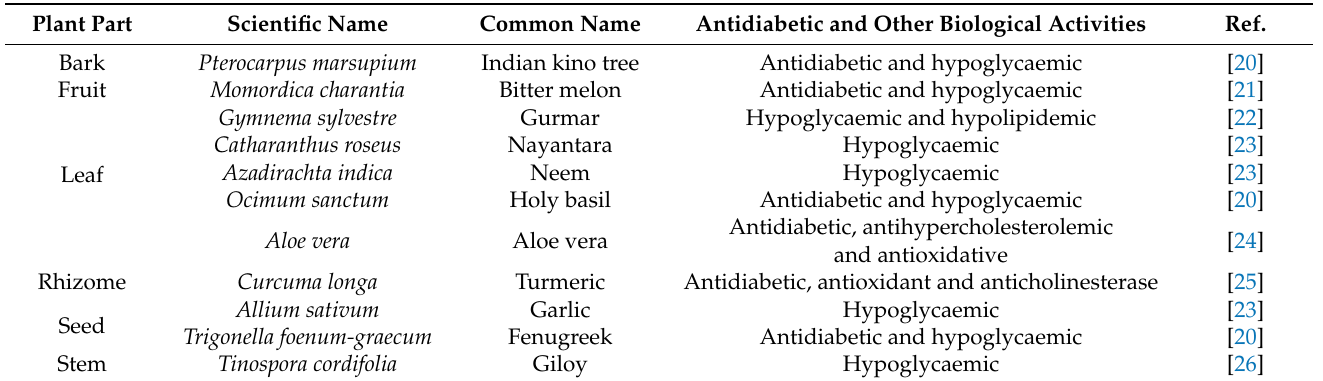
Table 1. Medicinal plants with antidiabetic